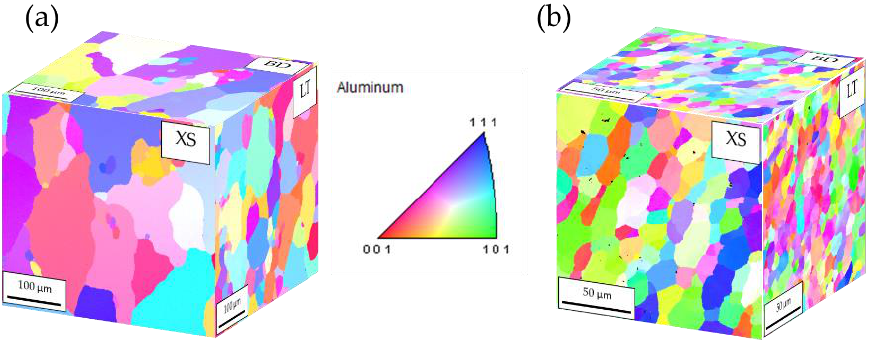
Figure 2. Isometric view of electron backscatter diffraction (EBSD) maps of ( a ) AA6061-T651 feedstock and ( b ) as-deposited AFS-D AA6061 with equiaxed grains.